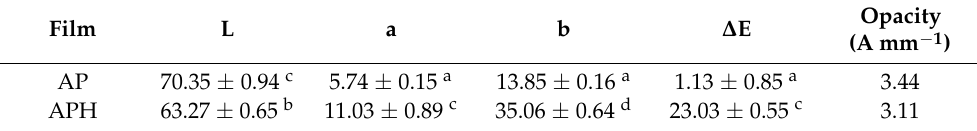
Table 1. Film color parameters and